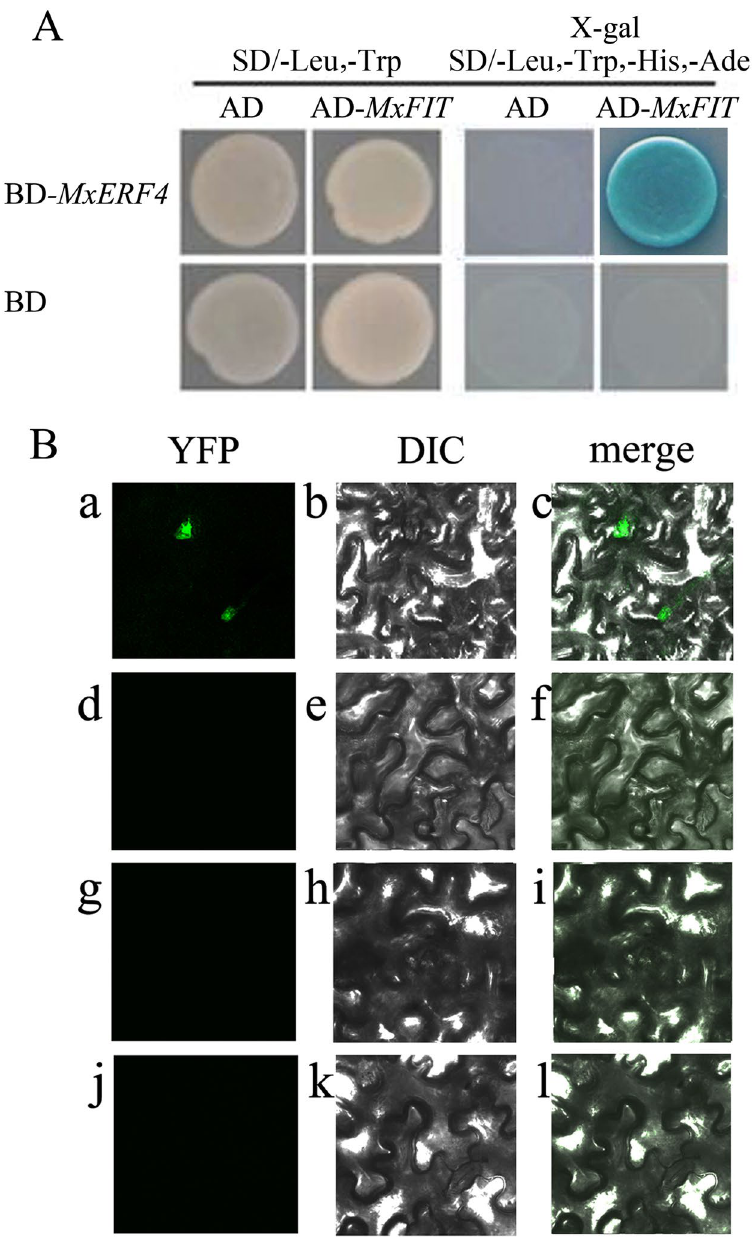
Figure 6. There is an interaction between MxERF4 and MxFIT. ( A ) Yeast two hybrid analysis of the physical interaction between the MxERF4 and MxFIT proteins. The protein interaction was examined using various combinations of prey and bait vectors. All tests were conducted on minimal medium/-Leu,-Trp or on minimal medium/-Leu,-Trp,-His,-Ade. Interactions were determined based on cell growth and were confirmed by an X-gal assay on minimal medium/-Leu,-Trp,-His,-Ade. ( B ) In planta protein interaction of MxERF4 and MxFIT. bimolecular fluorescence complementation (BiFC) of yellow fluorescent protein (YFP) in transiently transformed tobacco leaf epidermal cells. The left column ([a], [d], [g] and [j]) shows the YFP signal detected by confocal microscopy; the middle column ([b], [e], [h], and [k]) shows differential interference contrast (DIC) microscopy; the right column ([c], [f], [i], and [l]) shows merge images of the fluorescent signal and DIC. YC-MxFIT plus YN-MxERF4 ([a] to [c]); negative control YC plus YN-MxERF4 ([d] to [f]); YC-MxFIT plus negative control YN ([g] to [i]); negative control YC plus negative control YN ([j] to